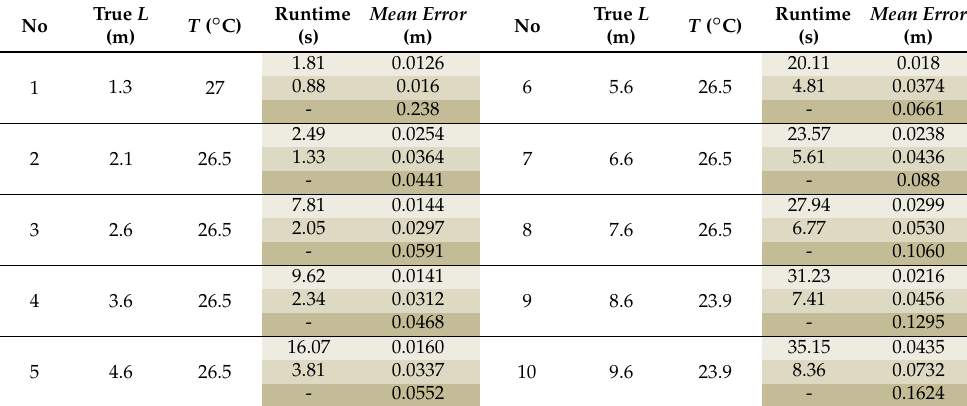
Table 3. Experimental results for different values of L.